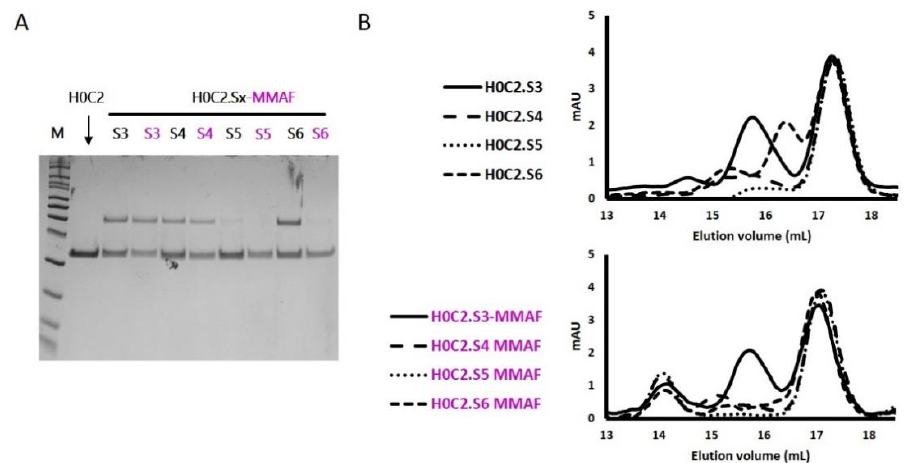
Figure 5. ( A ) Denaturating and non-reducting SDS-page analysis of fragments H0C2.Sx (x = 3 to 6), in native (black) and conjugated (purple) forms. ( B ) Analysis of native fragments H0C2.Sx (x = 3 to 6) and conjugated fragments H0C2.Sx-MMAF (x = 3 to 6), by size-exclusion chromatography (SEC). Table 2. Thermal stability of the native fragments H0C2, 4D5.2 and H0C2.Sx (x = 3 to 6), and conjugated fragments 4D5.2-MMAF and H0C2.Sx-MMAF (x = 3 to 6). Tm: melting temperature (corresponding to 50% of unfolded protein); ∆ Tm and ∆ Tm (C − Ref): variation of Tm in comparison to the reference fragment H0C2; ∆ Tm (C − N): variation of Tm between a conjugated fragment and its native